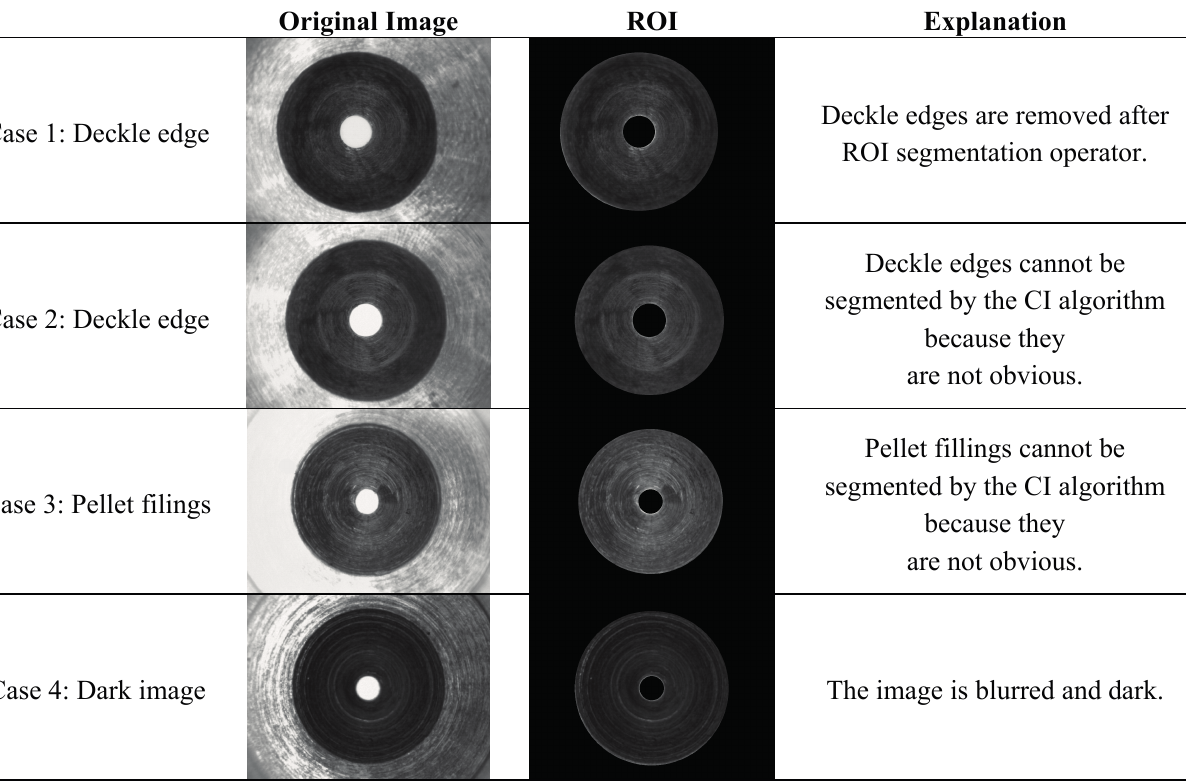
Table 2. Examples of classification failure and